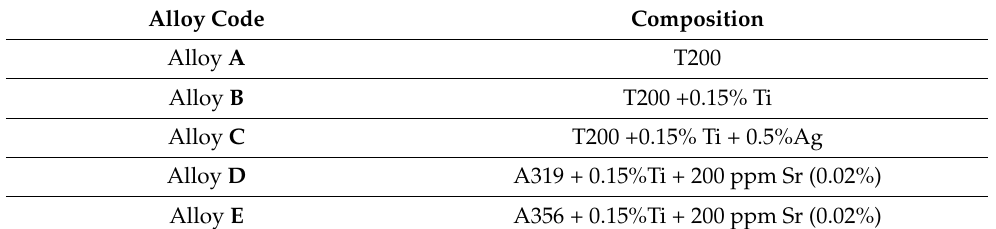
Table 2. Compositions of the five alloys used for this